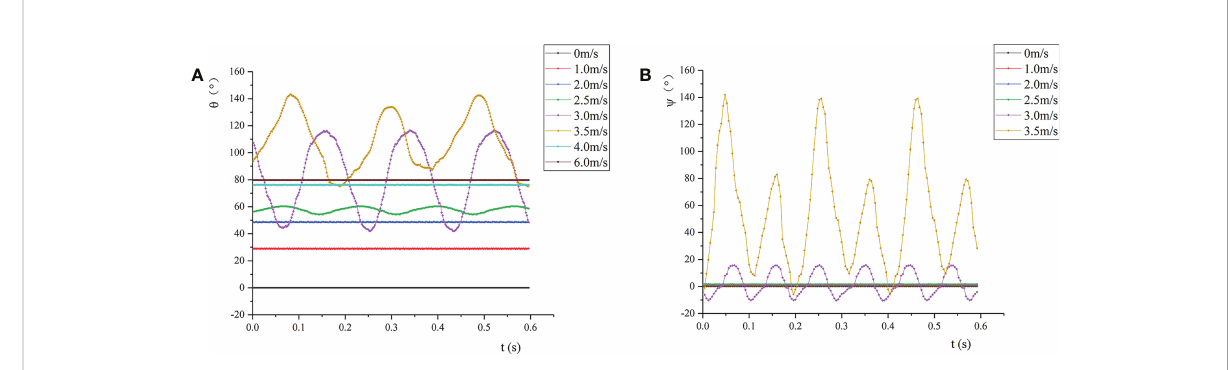
FIGURE 7 Wind de fl ection angle and twist angle of the leaf at different air velocities: (A) Wind de fl ection angle; (B) twist